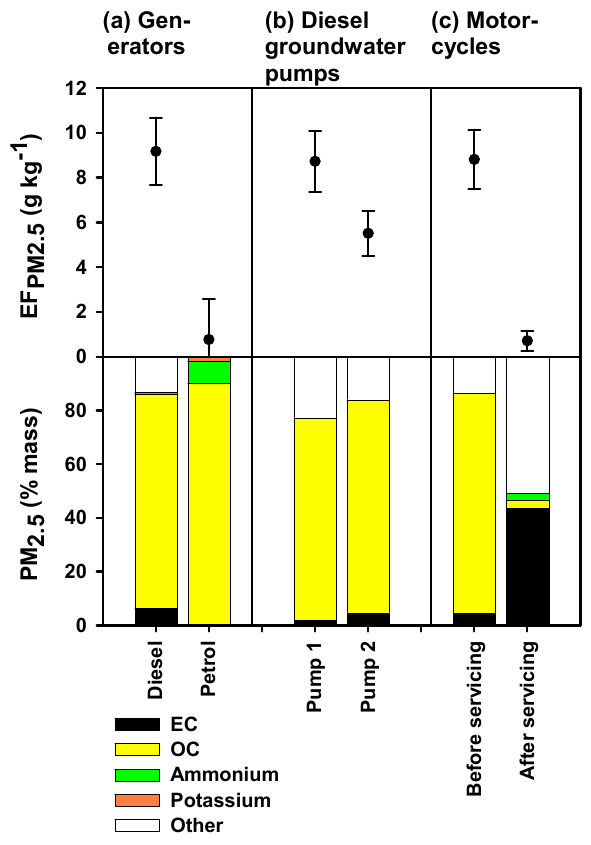
Figure 3. EF PM and PM 2 . 5 composition (as percent by mass) 2 . 5 for generators (a) , diesel groundwater pumps (b) , and motorcycles before and after servicing (c) . Error bars correspond to analytical